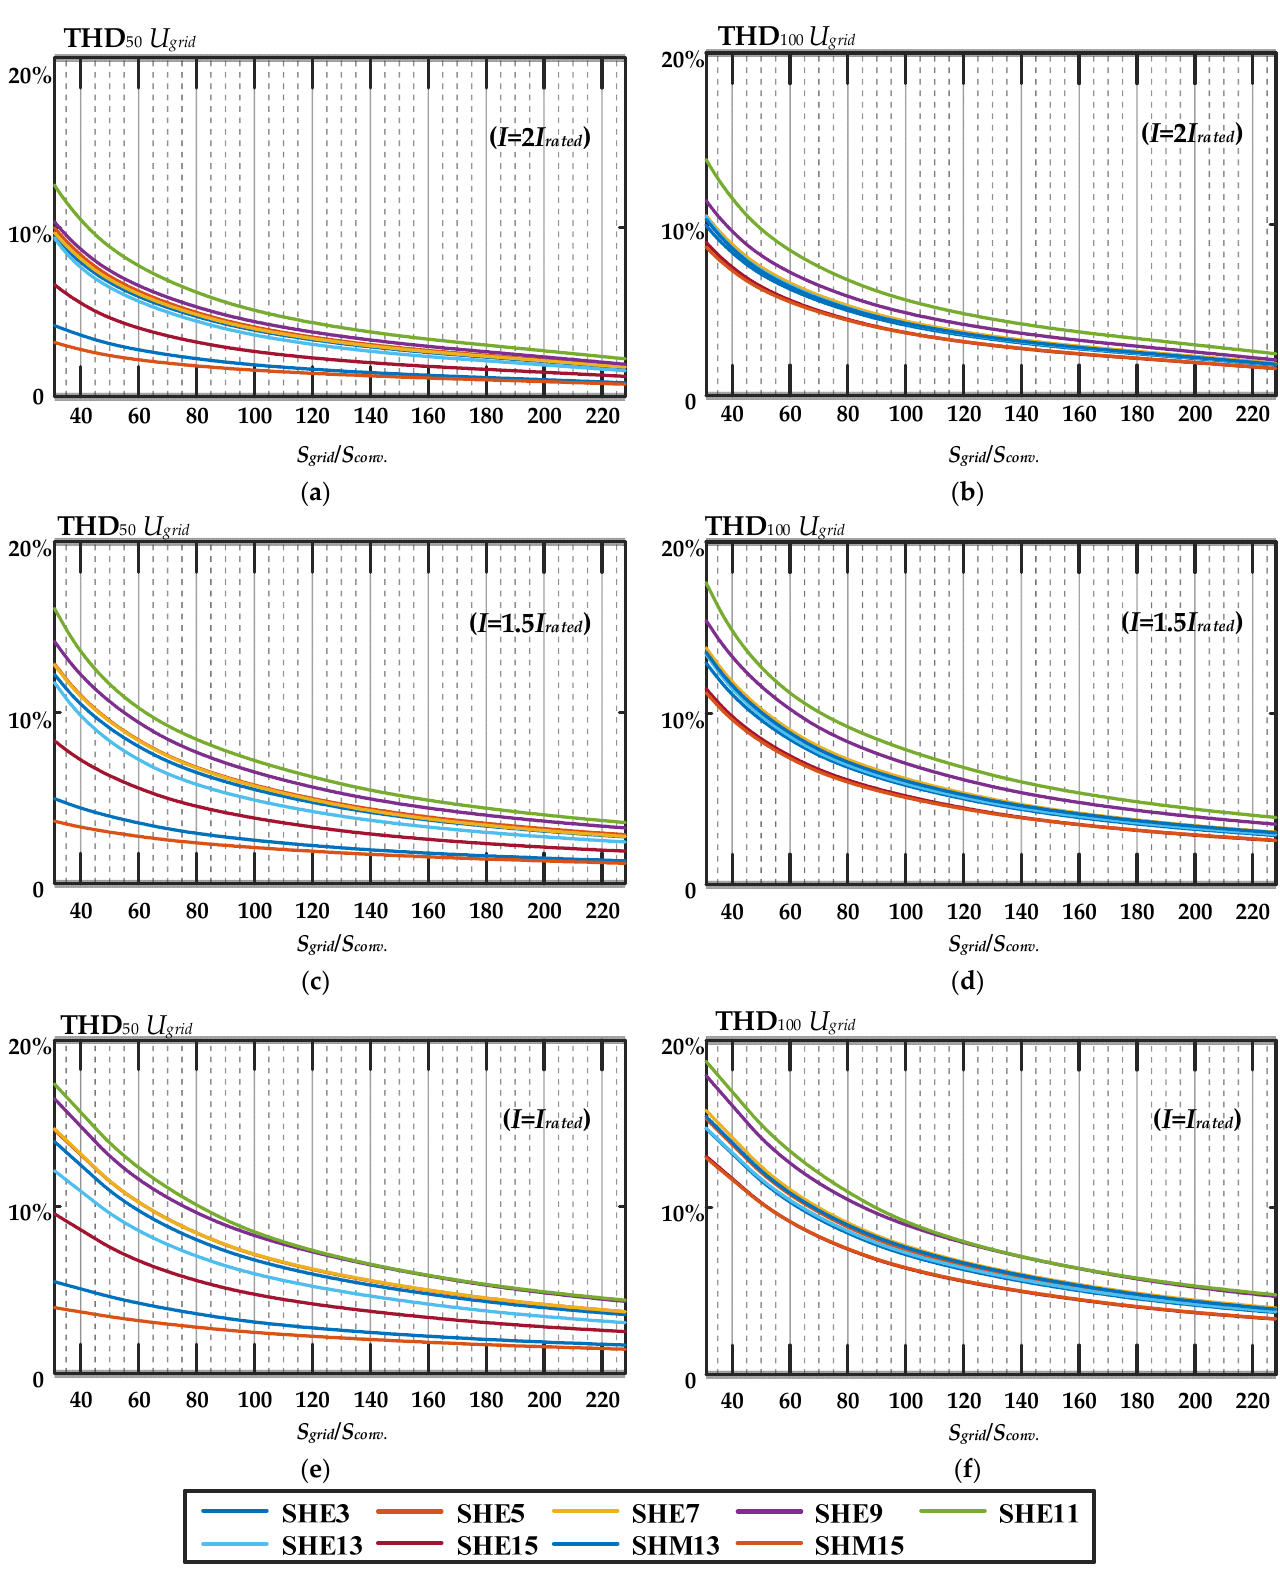
Figure 8. THD comparisons of U grid between the harmonics up to the 50th order ( a – c ) and up to the 100th order ( d – f ).